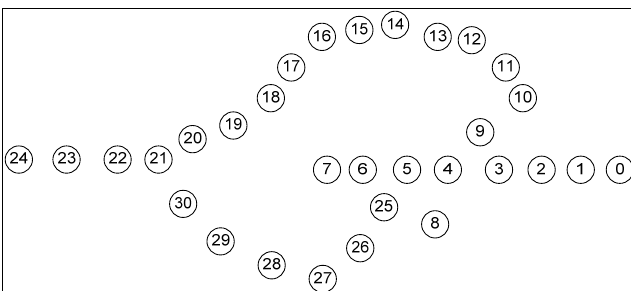
Figure 19. Closed void (best case